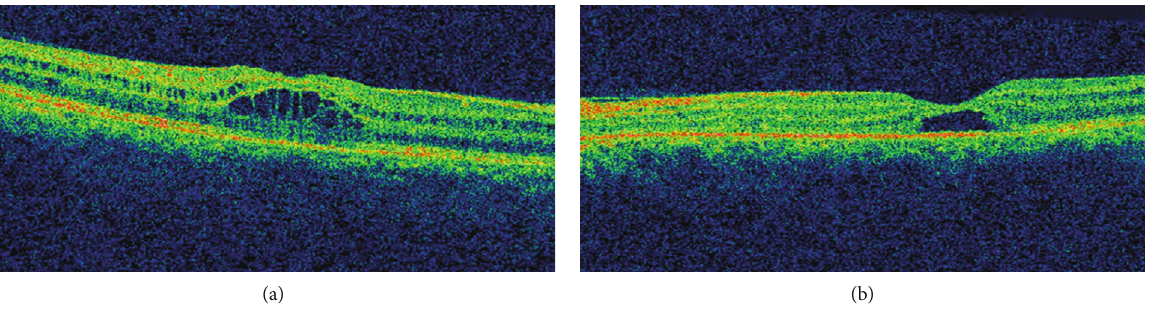
Figure 4: SD-OCT at two months following injury. (a) Right eye with interval development of intraretinal cystoid abnormalities. (b) Left eye with persistent foveal